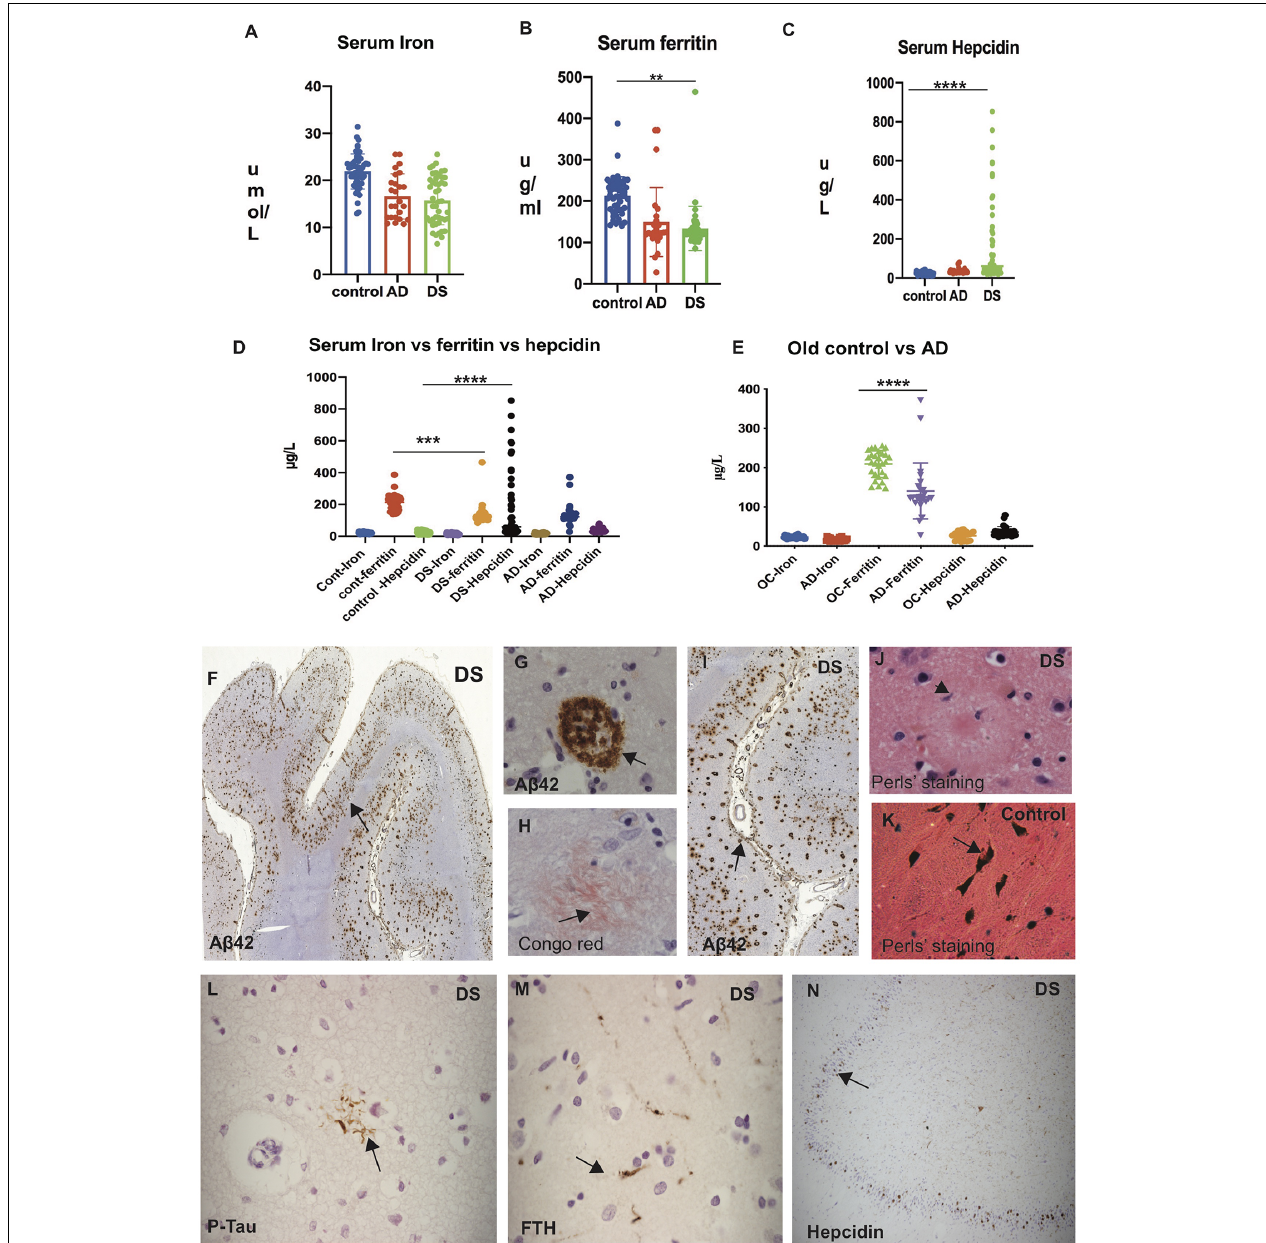
FIGURE 1 | Significant elevation of serum hepcidin in Down’s syndrome (DS) subjects and iron accumulation visible in DS senile plaques. Human serum from Alzheimer’s disease (AD), DS and age-matched control subjects showing iron (A) , ferritin (B) , and hepcidin ( C ; “Materials and Methods” section described in main text). Scattered plot showing levels of serum iron (A) and serum ferritin (B) significantly higher in control subjects compared to AD and DS ( p < 0.0001). In contrast, hepcidin levels were substantially higher in DS compared to AD and controls ( p < 0.0001; C ). Comparison of iron, ferritin and hepcidin level showing highest hepcidin levels in DS when compared to controls and AD individuals (D) . Serum samples from AD and age matched older controls (OC) on comparison showed the highest ferritin levels in OC compared to AD, whereas there were no significant differences in hepcidin levels (E) . Statistical differences were calculated by Mann–Whitney U test. ** p < 0.001, *** p < 0.0001 and **** p < 0.00001. DS brain sections from superior frontal gyrus (SFG) stained with DAB and anti-A β 42 antibody revealed strong signal of SPs positive for A β 42 and visible throughout the cortex ( F , black arrows highlighting the selected area of plaques formation, (G) in higher magnification inside the plaque formation and (I) close to the blood vessels. To confirm neurofibrillary (neuritic) plaque formation, a representative section was stained with Congo red (H) showing the amyloid proteins having apple-green birefringence under polarized light in senile plaques (SP). Perls’ stain identifies the ferric (Fe3+) form of iron, showing limited ferric iron was visible albeit only in the glial cells periphery of senile plaques (J) , and in controls particularly seen in neuromelanin cells of substantia nigra pars compacta (SNPC) in controls (K) . Similarly, a section from mid temporal gyrus (MTG) was stained with phospho-tau (AT8) showing neurofibrillary tangle close to glial cells (L) , and some of those neuro-filaments were ferritin (FTH) positive (M) . In the hippocampus of DS brain section, granule cells were positive for hepcidin (N) . Scale bar: (F and I) = 200 µ m, (L–N) = 50 µ m, (G,H,J,K) = 25 µ m.